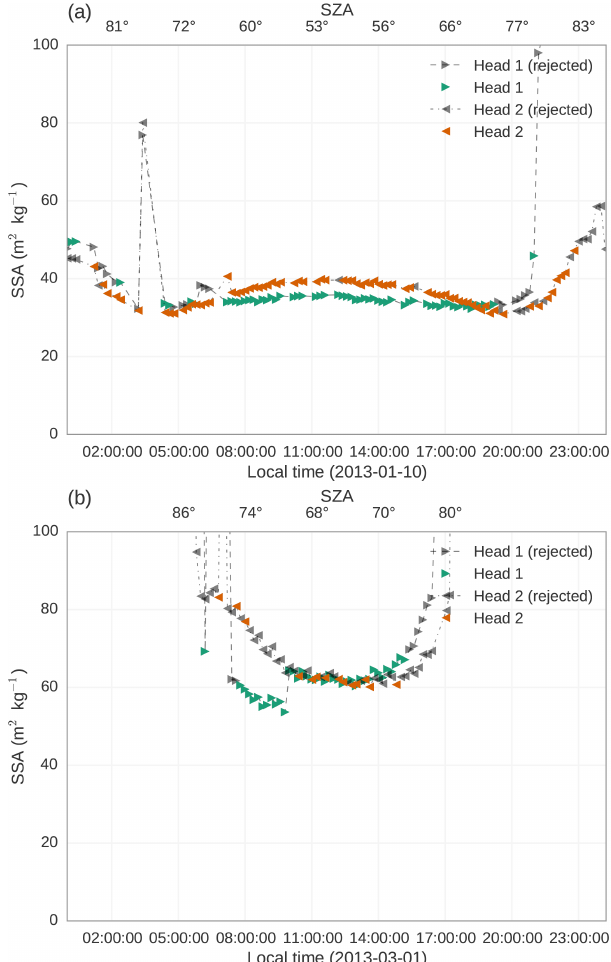
Figure 13. Diurnal variations of estimated SSA for 10 January 2013 (top) and 1 March 2013 (bottom) for the two heads. Gray symbols show data rejected by the quality